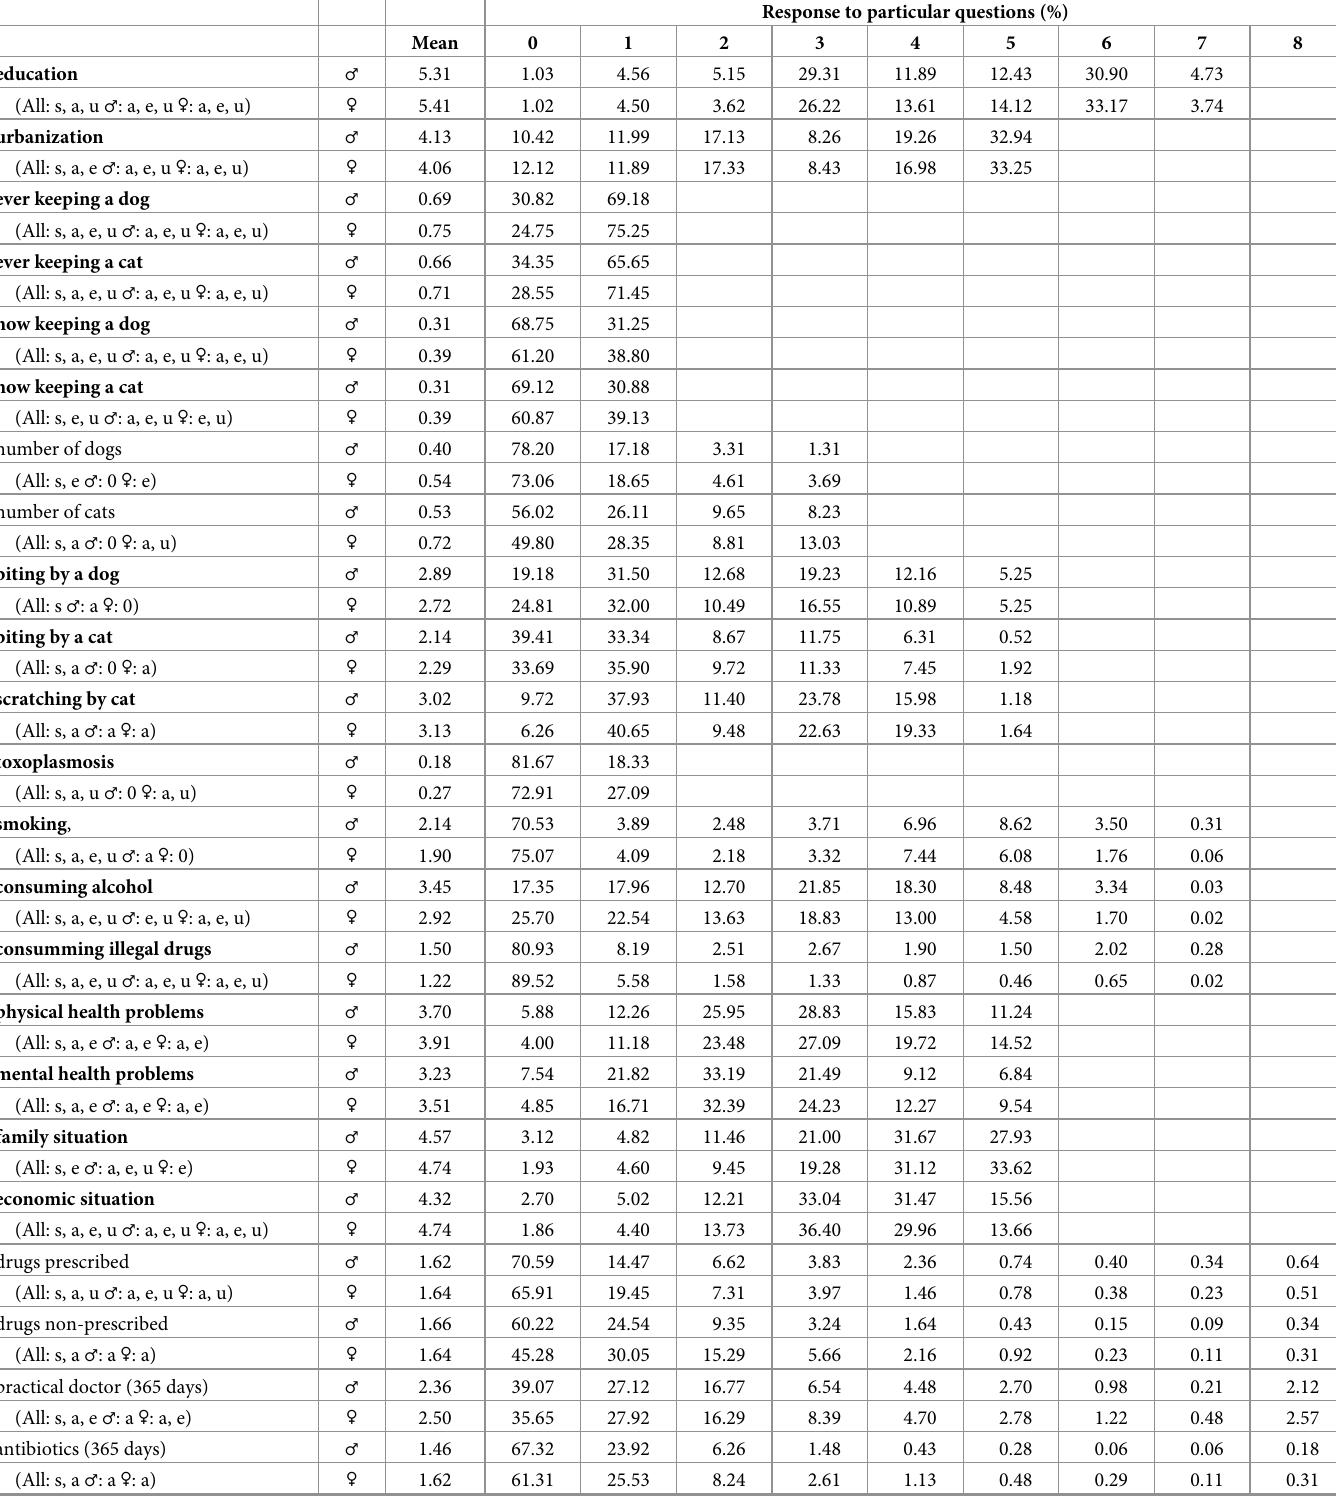
Table 2. Distribution of responses on particular questions of the questionnaire—Categorical and ordinal